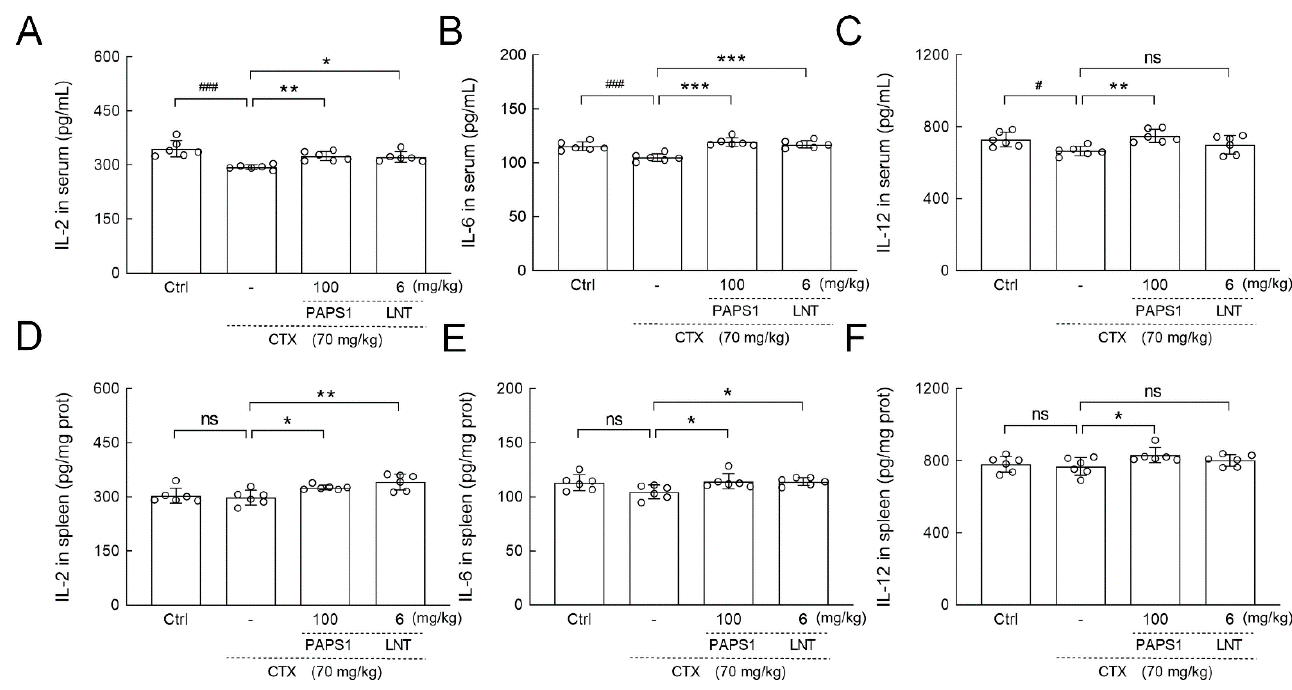
Figure 6. PAPS1 regulated the levels of inflammatory cytokines in the serums and spleens of CTX- immunosuppressed mice. The levels of ( A ) IL-2, ( B ) IL-6, ( C ) IL-12 in the serums, and ( D ) IL-2, ( E ) IL-6, ( F ) IL-12 in the spleens were detected by ELISA. Data are presented as the mean ± S.D. ( n = 6) and were analyzed via a one-way ANOVA test followed by Dunn’s multiple comparisons post hoc tests. ns > 0.05, # p < 0.05 and ### p < 0.001, compared with Ctrl mice; ns > 0.05, * p < 0.05, ** p < 0.01 and *** p < 0.001, compared with CTX-only treated mice. The height of the column chart represents the means, and the circle represents the independent sample value within each group. Ctrl, control, CTX, cyclophosphamide; PAPS1, water-soluble PA polysaccharides, LNT, lentinan; IL, Interleukin.